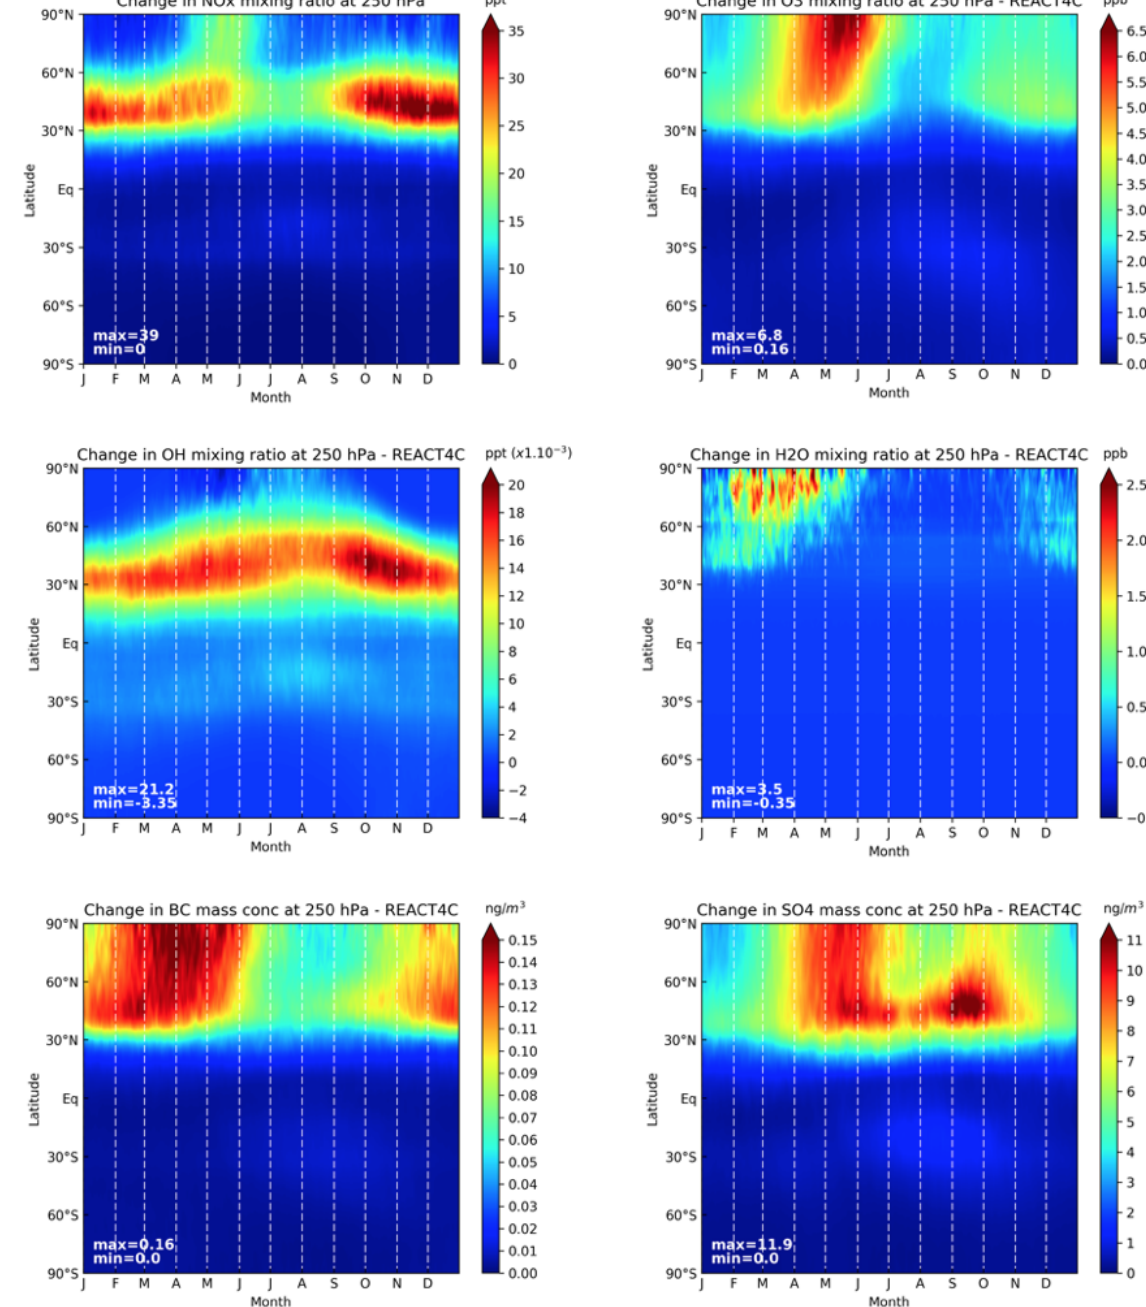
Figure 3. Daily and zonally averaged perturbations due to aircraft emissions at 250hPa of NO x (pptv), O 3 (ppbv), OH (10 − 3 pptv), H 2 O (ppbv), BC (ngm − 3 ), and SO 4 (ngm − 3 ) for the REACT4C_2006